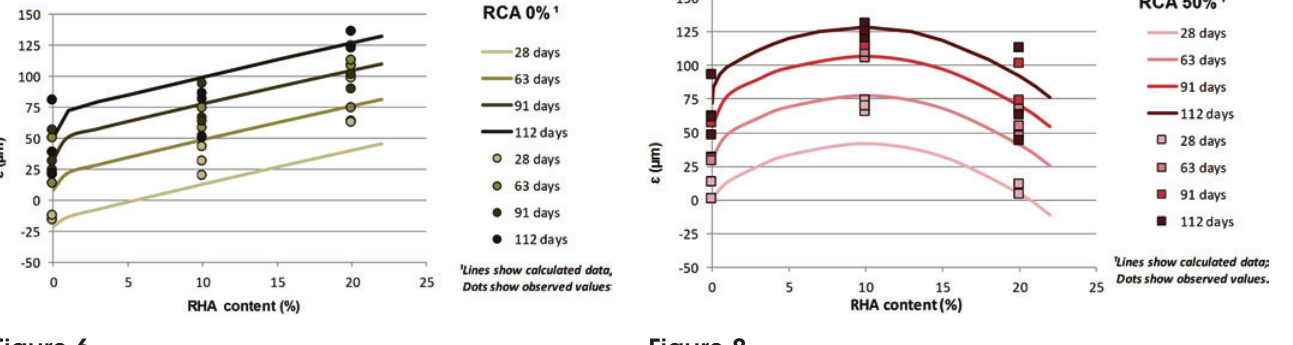
Shrinkage test, replacement with RHA with 50% RCA for mixtures of different ages